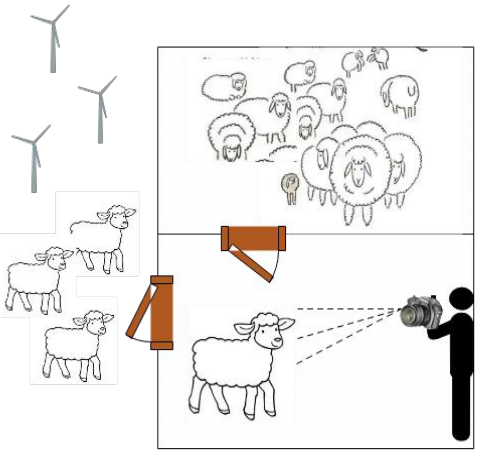
Figure 1. The layout of the experimental scene.